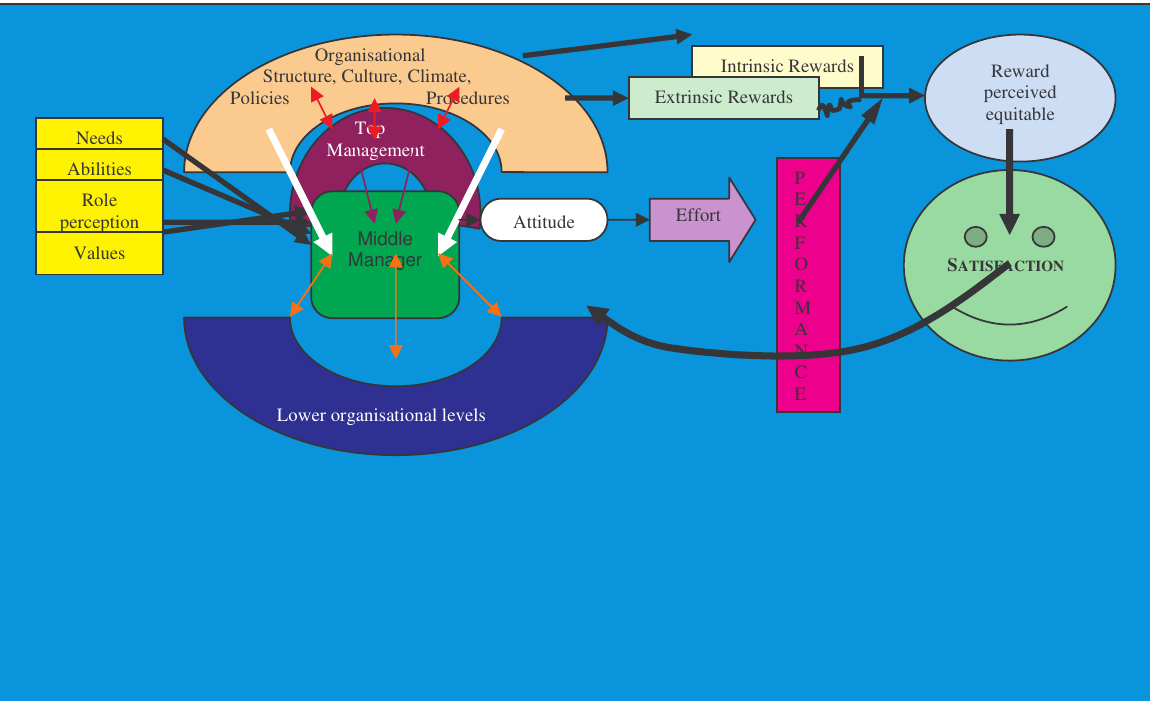
Figure 1: C ONCEPTUAL JOB SATISFACTION FRAMEWORK FOR MIDDLE